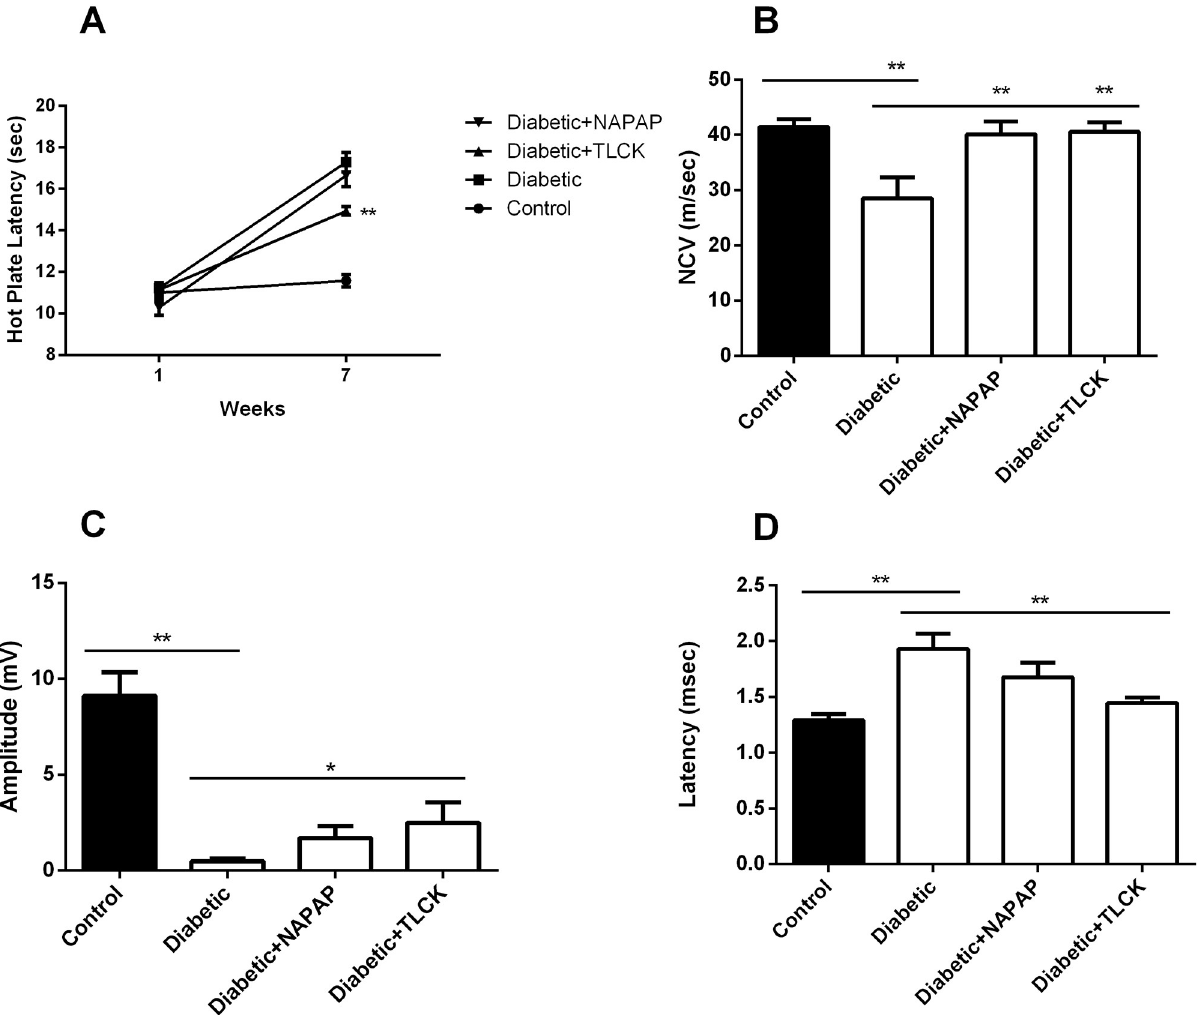
Fig 3. Heat response and nerve conduction impairments are improved by TLCK and partially by NAPAP. (A) Hot plate latency was significantly longer in diabetic rats compared to control (week 7). TLCK but not NAPAP treated rats had significantly shorter hot plate latencies compared to untreated diabetic rats. (B) Nerve conduction velocity was significantly decreased in untreated diabetic rats, and was preserved by treatment with NAPAP and TLCK. (C) CMAP amplitude was significantly reduced in diabetic rats as compared to control. Amplitudes were significantly increased in TLCK treated diabetic rats compared to untreated diabetic rats. NAPAP treatment showed a non-significant trend towards improvement in amplitude. (D) Latency time was prolonged in diabetic compared to control rats. Latency was preserved in TLCK treated rats. Data are represented as mean ± SEM. � p � 0.05, �� p � 0.01. Number of samples: Hot plate control (n = 8), diabetic-saline (n = 8), diabetic-NAPAP (n = 8), diabetic-TLCK (n = 7). Amplitude control (n = 4), diabetic saline (n = 5), diabetic-NAPAP (n = 5), diabetic-TLCK (n = 5). Latency control (n = 4), diabetic-saline (n = 5), diabetic-NAPAP (n = 5), diabetic-TLCK (n = 7). NCV control (n = 4), diabetic-saline (n = 5), diabetic-NAPAP (n = 5), diabetic-TLCK (n =